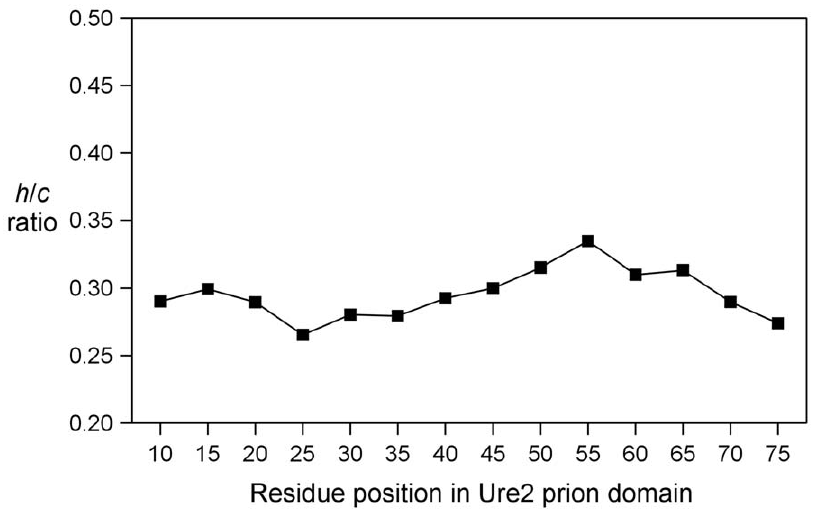
Figure 6. The h/c ratio plot for spin-labeled Ure2p 1–89 -M in PBS buffer containing 24% glycerol.